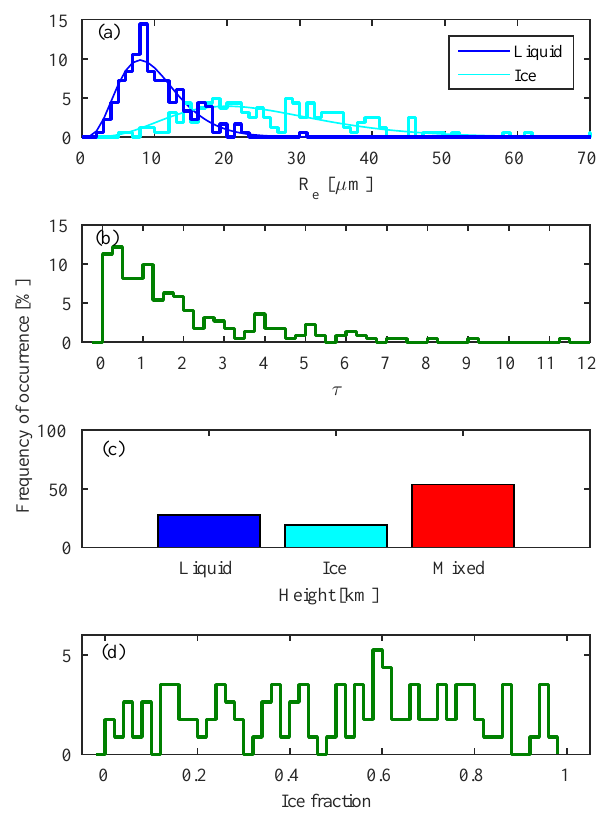
Figure 7. Distributions of microphysical properties for the 222 sim- ulated clouds. (a) Effective radius, (b) total (ice + liquid) optical depth, (c) phase, and (d) ice fraction (fraction of total optical depth) for mixed-phase